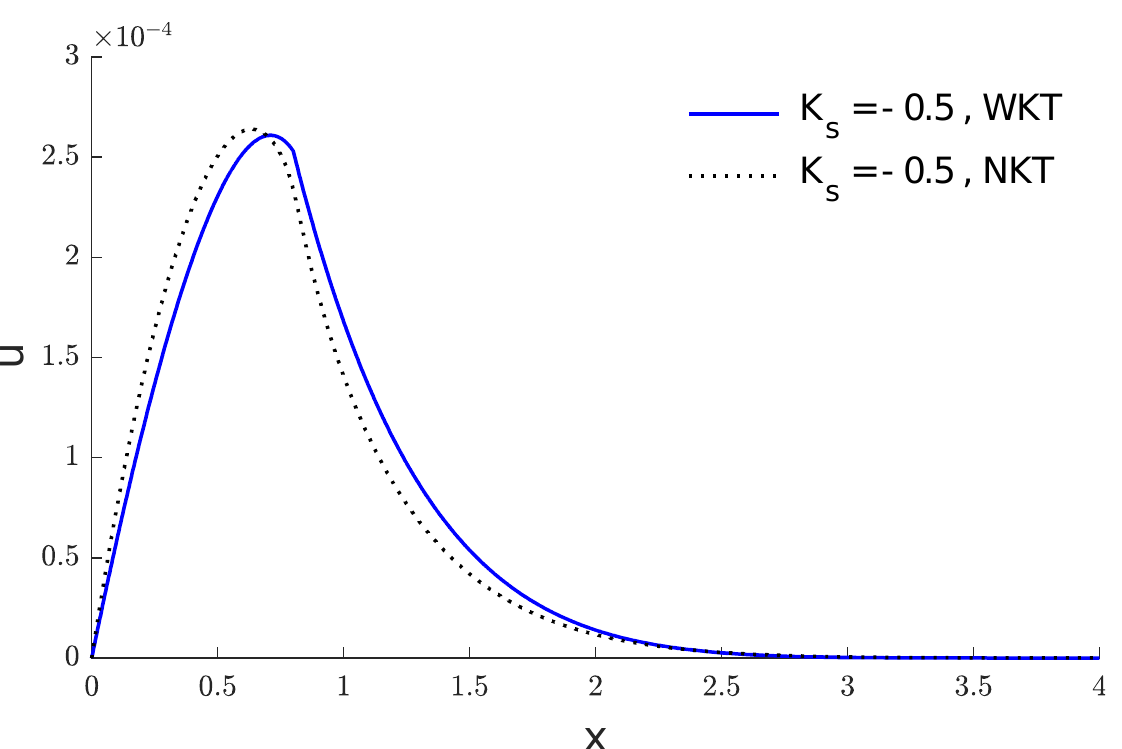
Figure 10. The variations of displacement with and without Kirchhoff transforms when 𝐾 𝑠 = −0.5 .